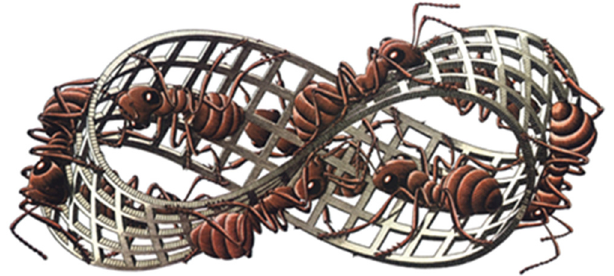
Figure 2: M.C. Escher, Mobius Strip II ( 1963 )